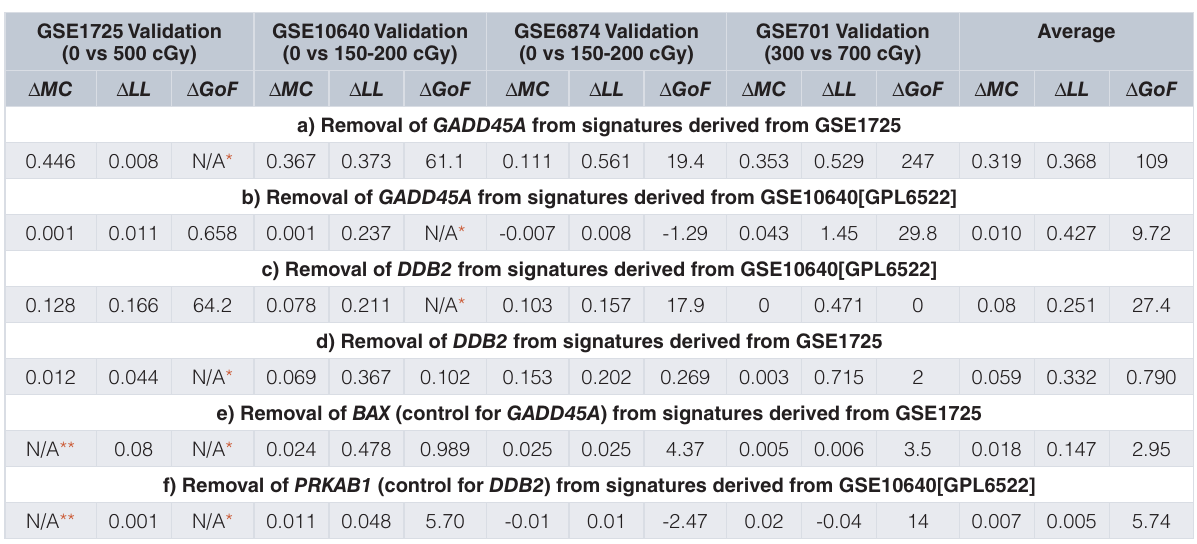
Table 4. Effect of removing genes from signatures of different